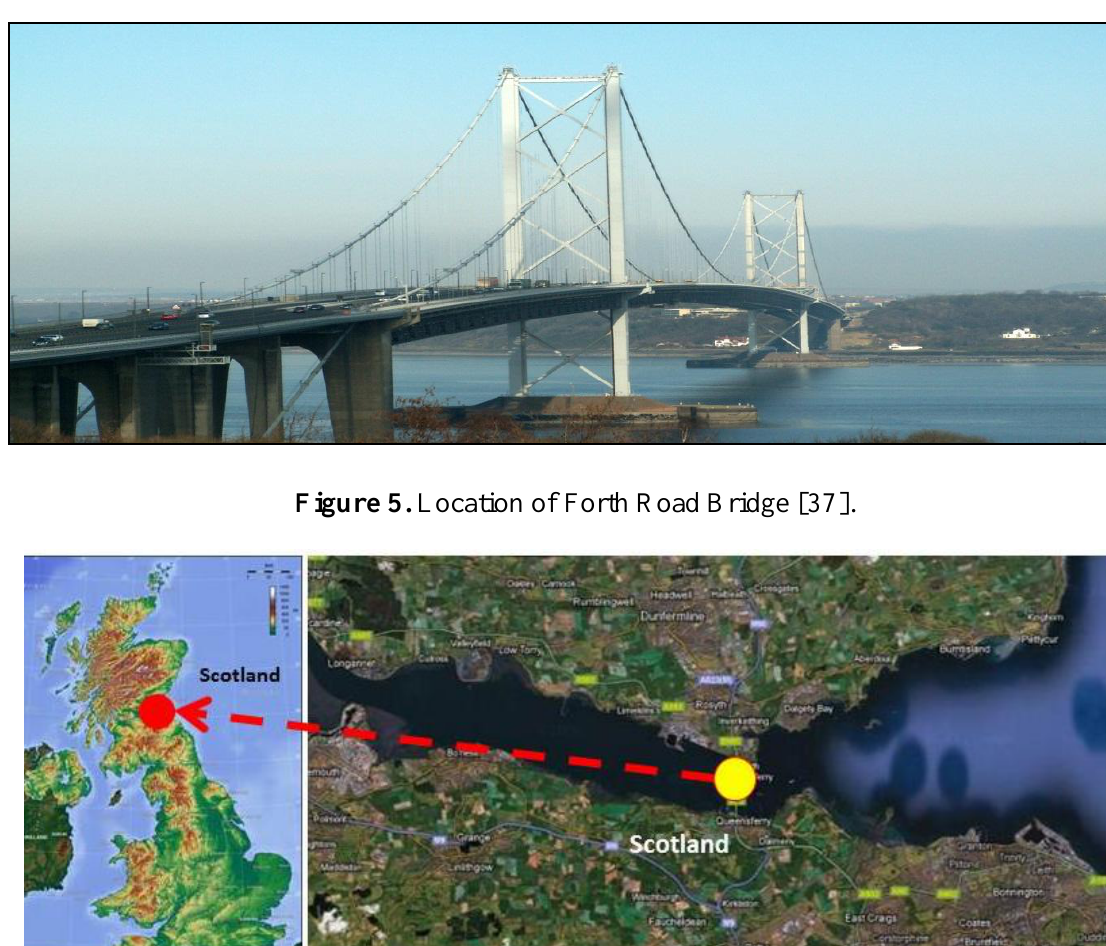
Figure 4. General view of the Forth Road Bridge [37].